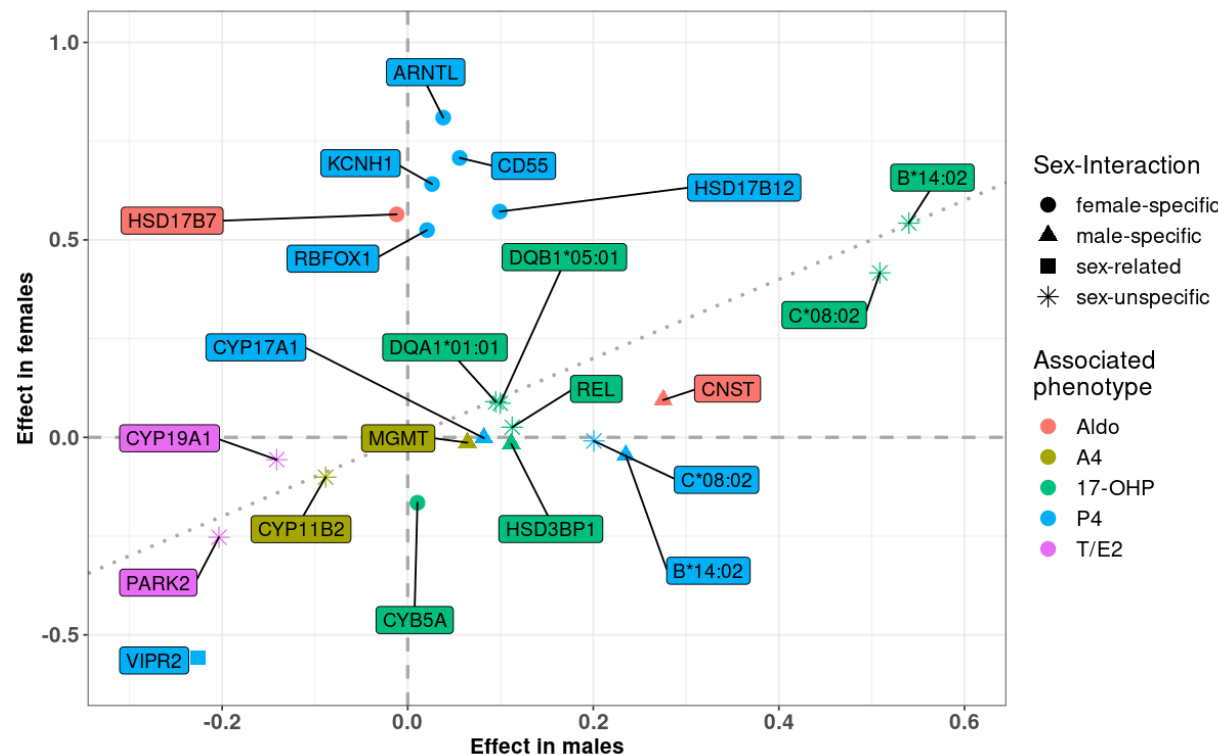
Figure 3. Scatter plot of sex-stratified effect estimates. Types of sex interactions are marked by shape (circle: female-specific; triangle: male-specific; square: sex-related; asterisk: no genetic sex interaction); and loci are colored by associated phenotypes. P4, progesterone; 17-OHP, hydroxyprogesterone; A4, androstenedione; Aldo, aldosterone; T/E2, ratio of testosterone and estradiol.